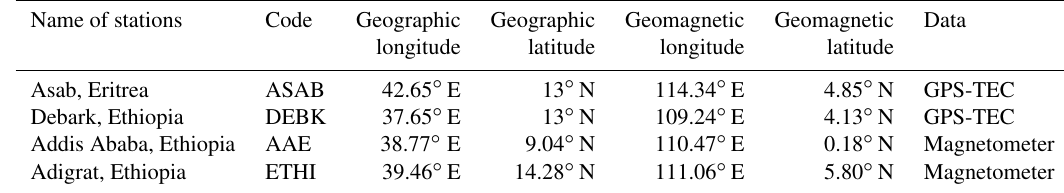
Table 1. Location information and the type of data used in this study. Name of